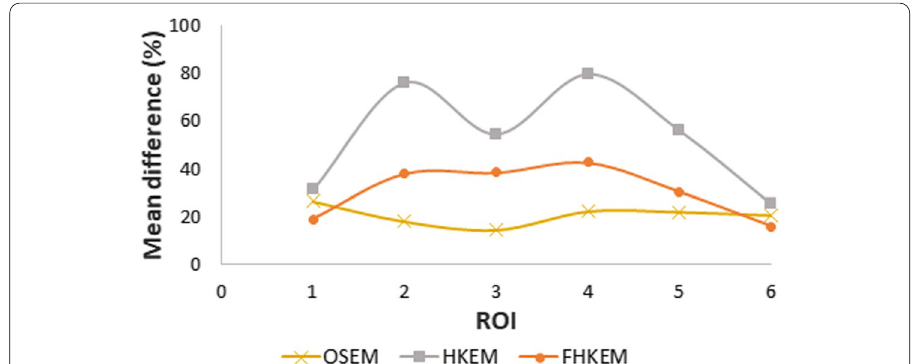
Fig. 5 Mean ROI difference between the images reconstructed with the measured PSF (mPSF) model and the estimated PSF (ePSF) model. The plot shows the case of images reconstructed with OSEM, HKEM, and FHKEM. The mean difference is plotted against the ROI number